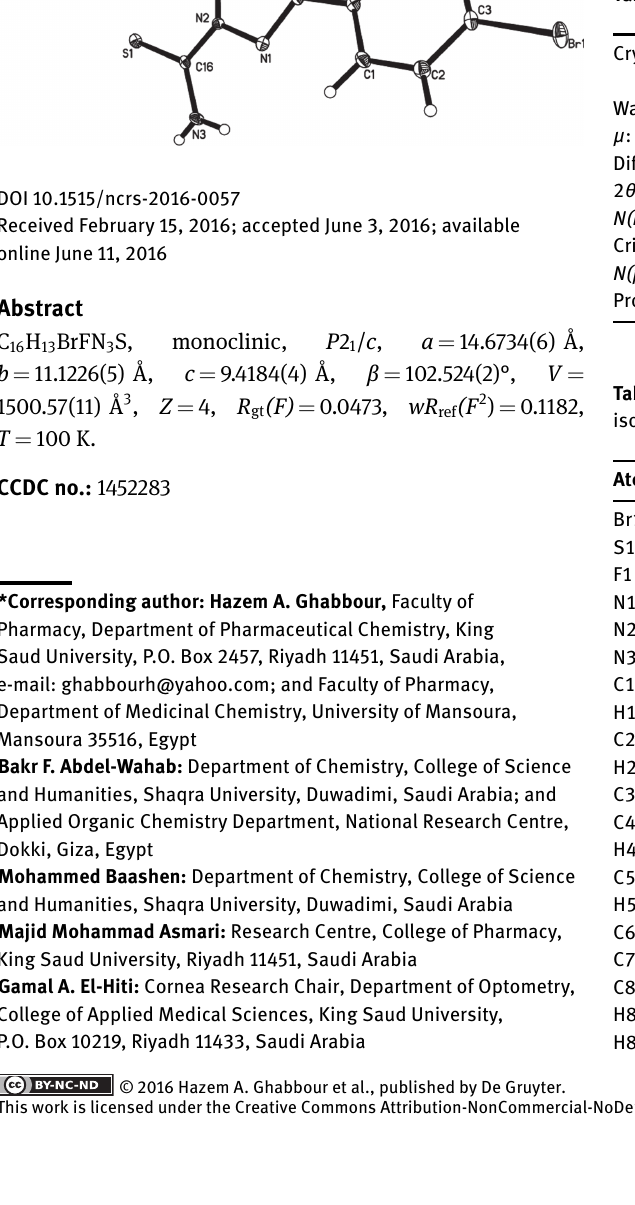
Table 1: Data collection and handling.